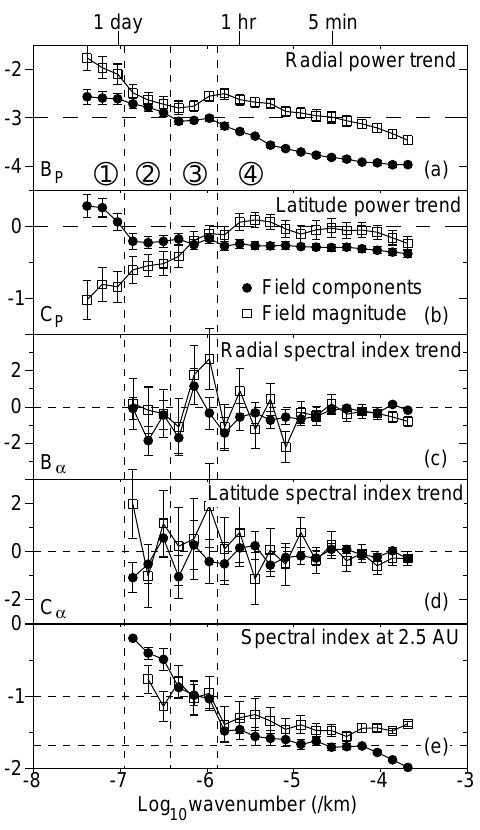
Figure 58: (a) Scale dependence of radial power, (b) latitudinal power, (c) radial spectral index, (d) latitudinal spectral index, and (e) spectral index computed at 2.5 AU. Solid circles refer to the trace of the spectral matrix of the components, open squares refer to field magnitude. Correspondence between wave number scale and time scale is based on a wind velocity of 750 km s –1 . Image reproduced by permission from Horbury and Balogh (2001), copyright by